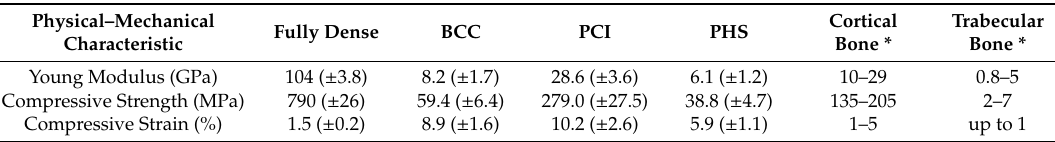
Physical–mechanical properties of Ti6Al7Nb lattice specimens SLM-manufactured (mean ± standard deviation).